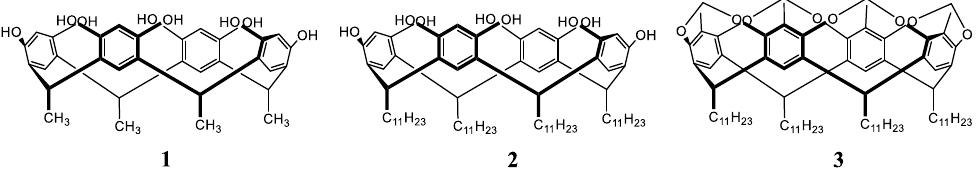
Figure 6. Chemical structures of calix[4]resorcinols 1, 2 and calix[4]resorcinol cavitand 3. A stabilizing effect on DPPC liposomes was also achieved by calix[4]arenes SC4AB and SC4AH substituted with sulfonate groups at the upper rim and alkyl tails at the lower rim (Figure 7) [127]. The average size of liposomes embedded with calixarene was around 100 nm with addition of SC4AH and SC4AB to 5 and 10 mol%, respectively. A further increase in the calixarene content led to the destruction of large aggregates to particles with a size of 20–60 nm. The negative surface charge of DPPC-SC4AH